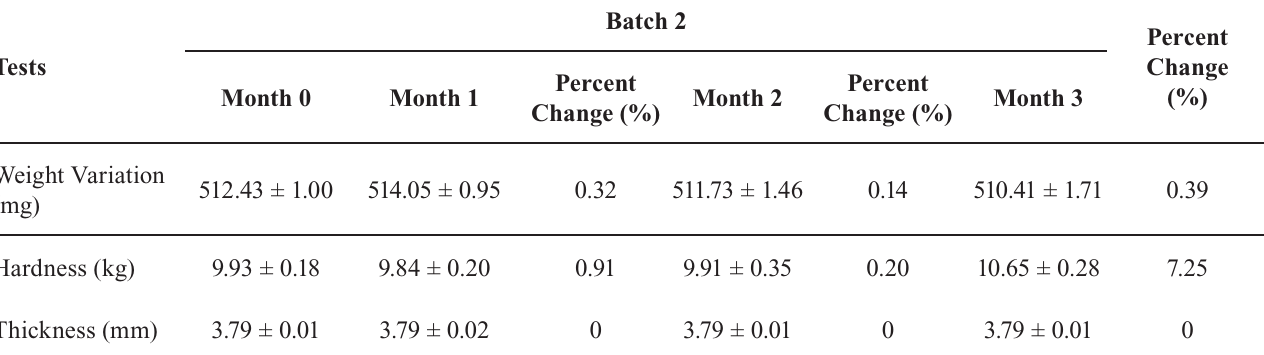
TABLE VI - Summary of the results for Batch 2: formulated mucoadhesive mefenamic acid buccal tablet